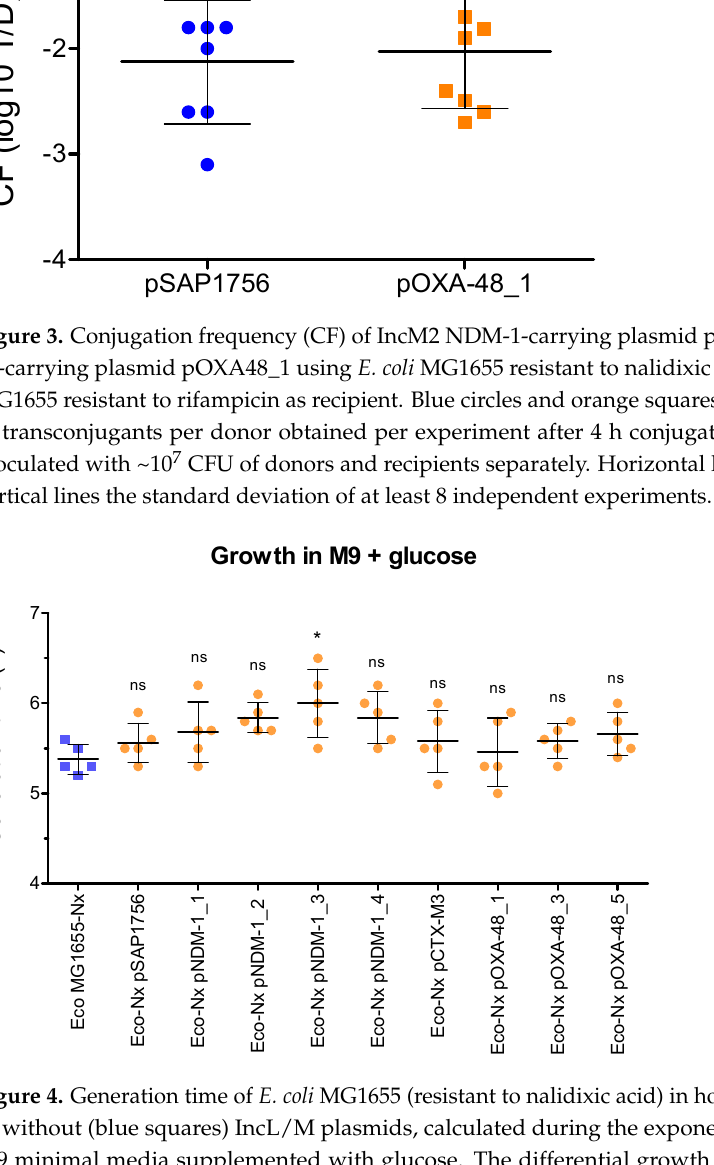
Figure 3. Conjugation frequency (CF) of IncM2 NDM-1-carrying plasmid pSAP1756 and IncL OXA- 48-carrying plasmid pOXA48_1 using E. coli MG1655 resistant to nalidixic acid as donor and E. coli MG1655 resistant to rifampicin as recipient. Blue circles and orange squares represent the logarithm of transconjugants per donor obtained per experiment after 4 h conjugation in Galleria mellonella inoculated with ~10 7 CFU of donors and recipients separately. Horizontal lines show the mean and vertical lines the standard deviation of at least 8 independent experiments.